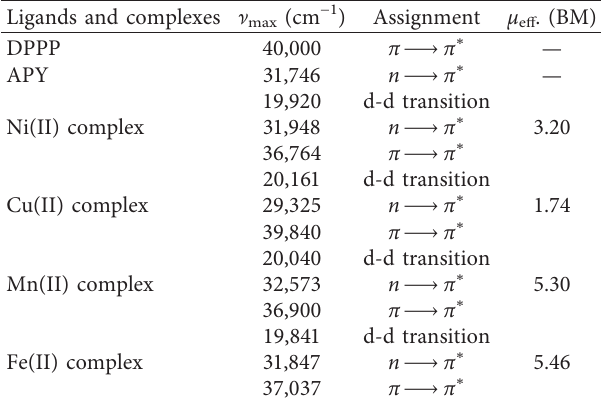
Table 3: Electronic spectral data of free ligand and its